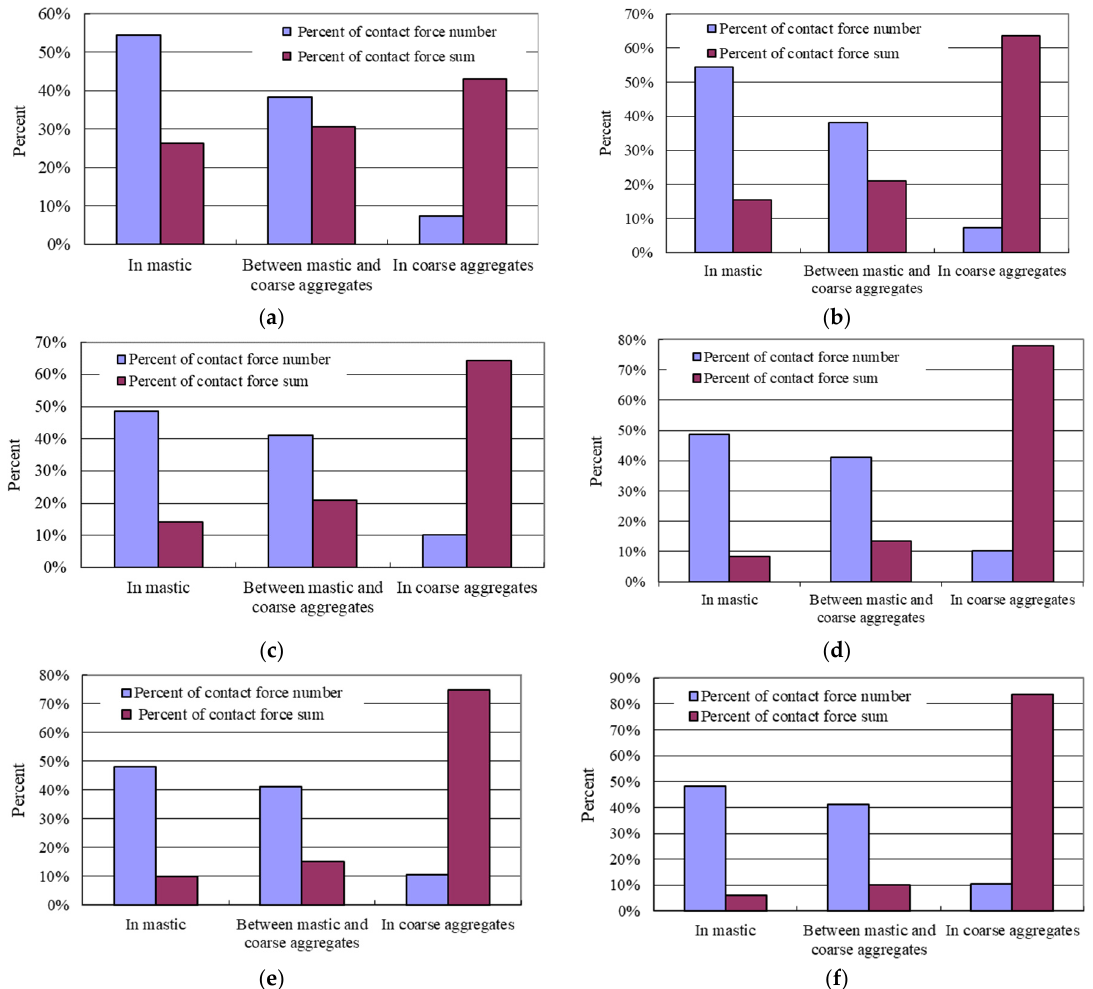
Figure 6. Percent of the contact forces in the asphalt mixture of each layer. ( a ) Normal contact force in the upper layer. ( b ) Tangential contact force in the upper layer. ( c ) Normal contact force in the middle layer. ( d ) Tangential contact force in the middle layer. ( e ) Normal contact force in the lower layer. ( f ) Tangential contact force in the lower layer.